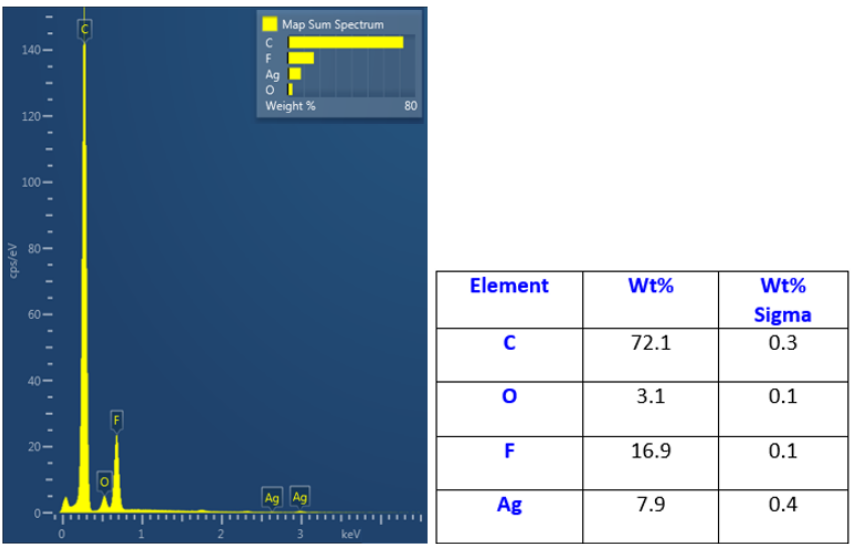
Figure 8. EDS spectrum of immobilized honeycomb pattern with silver acquired from a 30 × 30 μ m 2 area and corresponding elemental concentrations in the bottom part of the figure.